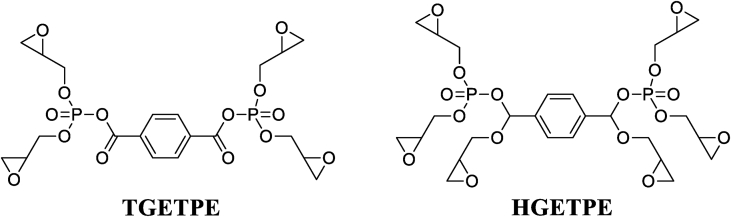
Structures of TGETPE and HGETPE [18].